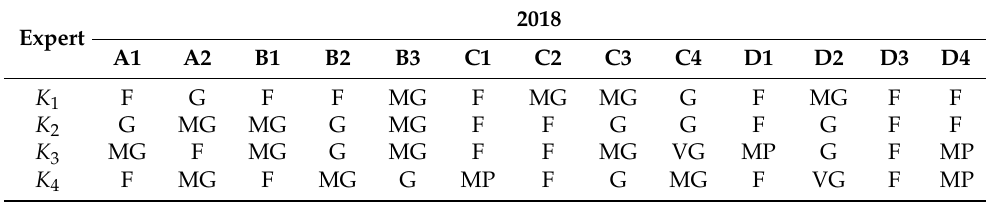
Table 11. Resilience rating scale of Shaanxi Province coal industrial chain and supply chain (2018).